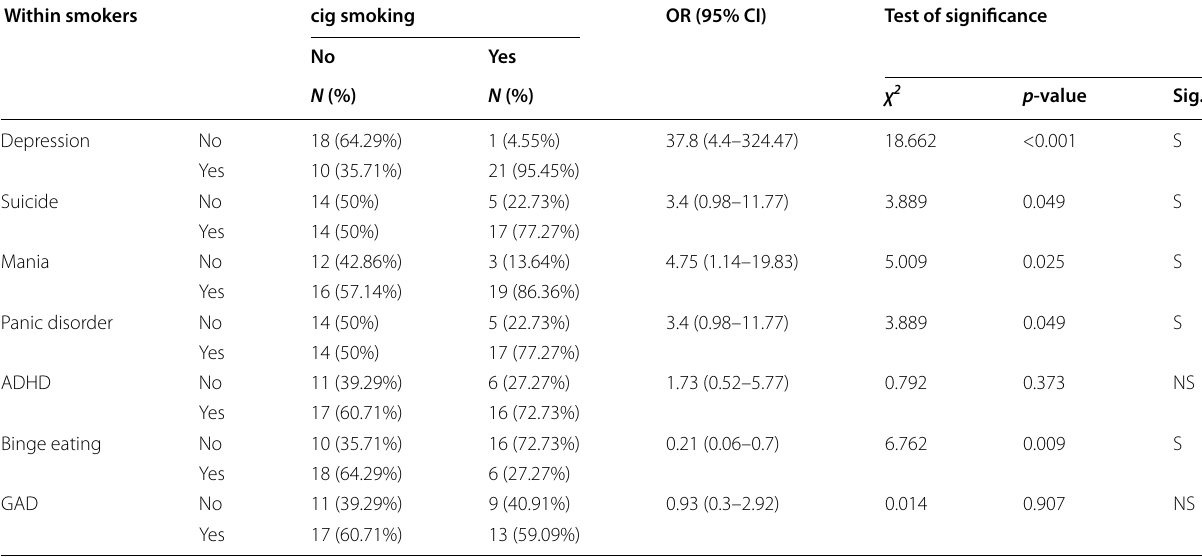
Table 5 Psychiatric symptoms in adolescents smoking cigarettes versus other types of smoking according to MINI-KID Within smokers cig smoking OR (95%